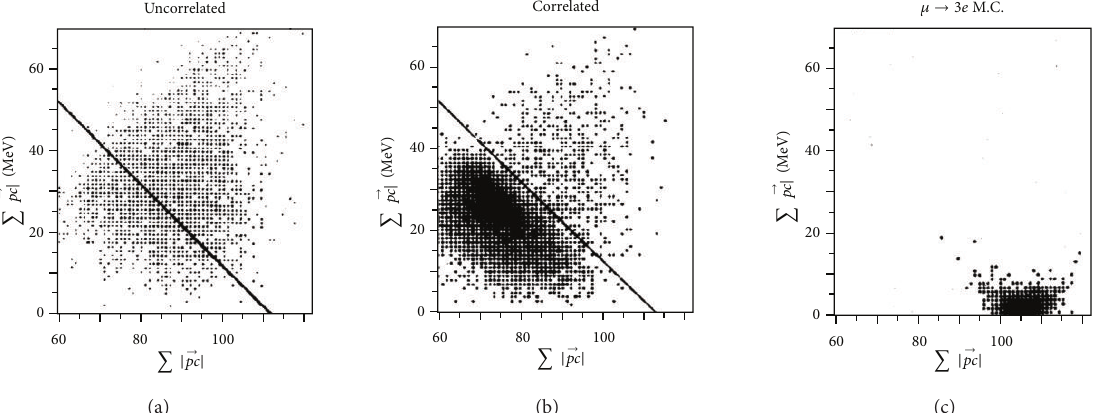
Figure 19: Distribution of triplets of tracks collected by SINDRUM experiment in the (total energy, total momentum) plane. (a) Uncorrelated events; (b) correlated events; (c) MC simulation. The diagonal line is the kinematical limit imposed by a muon decaying at rest for events coming from RMD decay, with internal conversion of the photon in a positron-electron pair (taken from [69]).